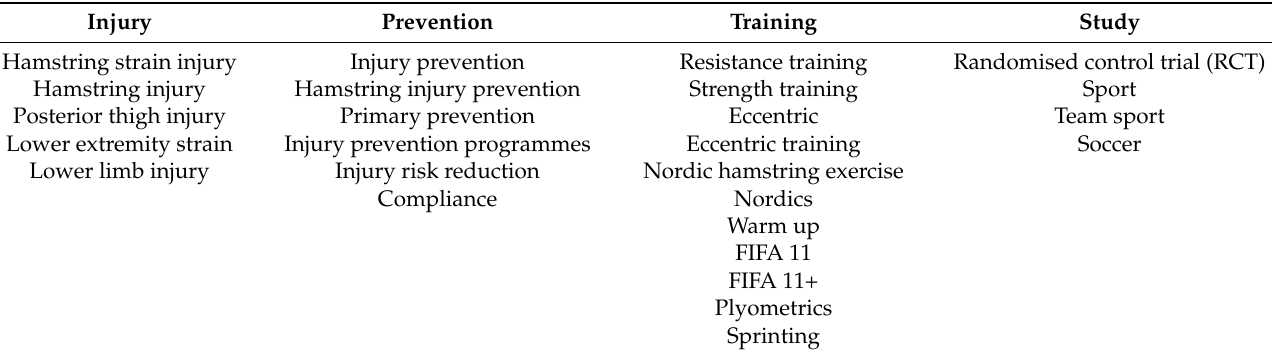
Table 1. Summary of keyword grouping employed during database